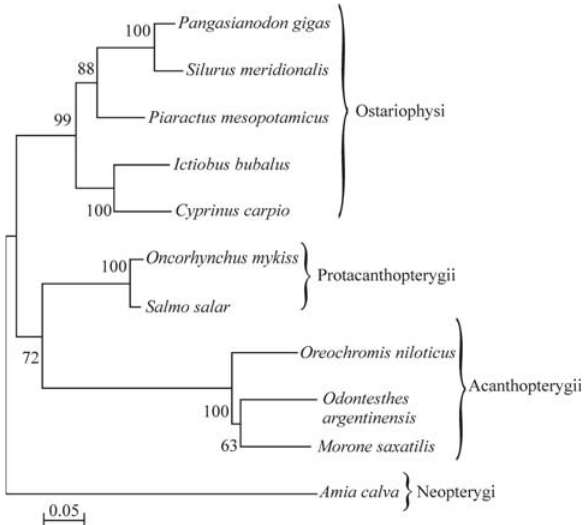
Figure 2 - Neighbor-joining tree generated from mature GH nucleotide sequences of several Telostomi species using the Kimura-two-parameter model. Numbers at branch points are bootstrap support percentages based on 5000 pseudoreplicates. Accession numbers for the nucleotides GH se- quences are: AY375301 for Ictiobus bubalus, the smallmouth buffalo; M27000 for Cyprinus carpio , the common carp; DQ206404 for Piaractus mesopotamicus , the pacu, L27835 for Pangasianodon gigas , the giant cat- fish; AF530481 for Silurus meridionalis , the southern catfish; X14305 for Salmo salar , the Atlantic salmon; M24683 for Oncorhynchus mykiss , the rainbow trout; S78253 for Morone saxatilis , the striped sea-bass; M97765 for Oreochromis niloticus , the Nile tilapia; AF236091 for Odontesthes argentinensis , the Argentinean silverside; and S73969 for Amia calva , the